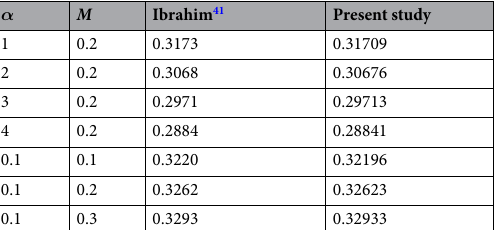
Table 1. Comparison of friction factor ( C F ) for different values of α and M when